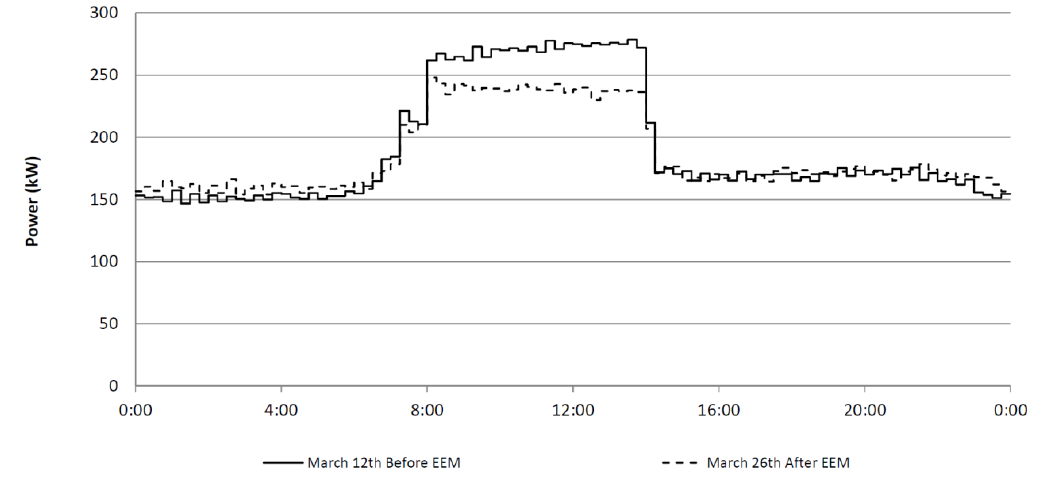
Figure 5. Building 8G consumption before and after the EEM (Saturdays).